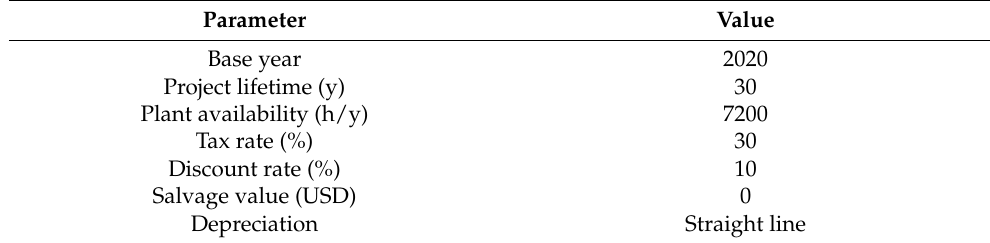
Table 1. Economic parameters and